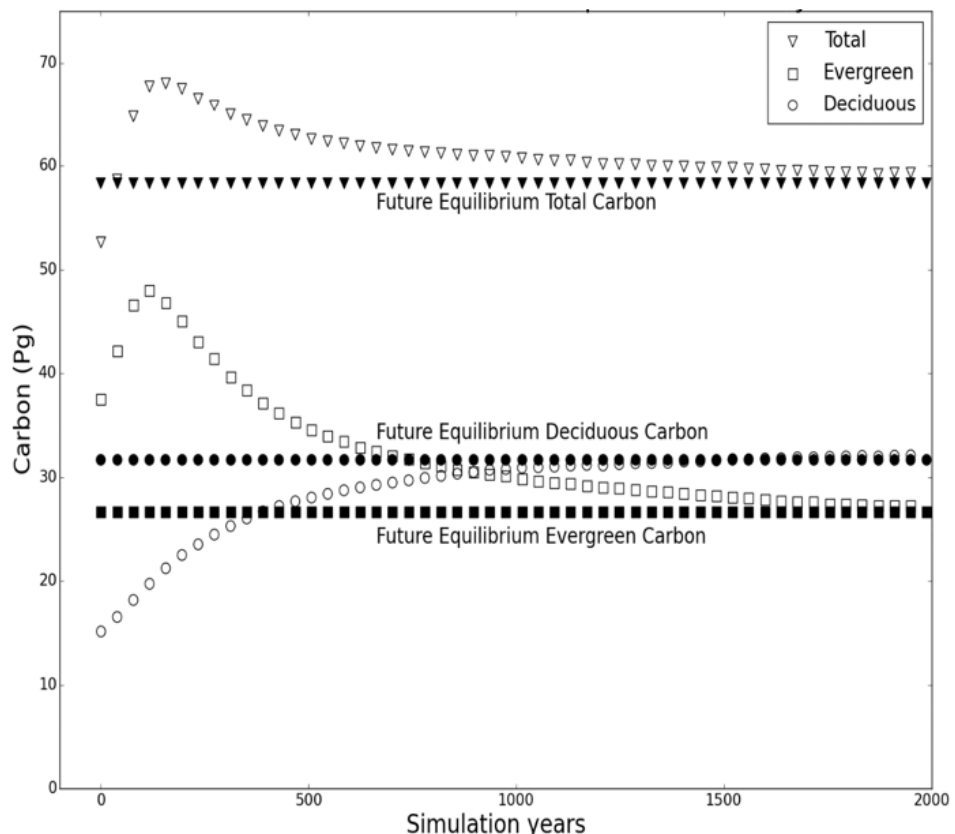
Figure 8. The temporal response from plant migration of carbon and the contribution from each PFT for the case of directed dispersal at 10 km per year under standard disturbance. The predicted equilibrium response total carbon, and the portion from each PFT, are shown in black. The transient response total carbon and the portion from each PFT are shown in white and change with simulation year.